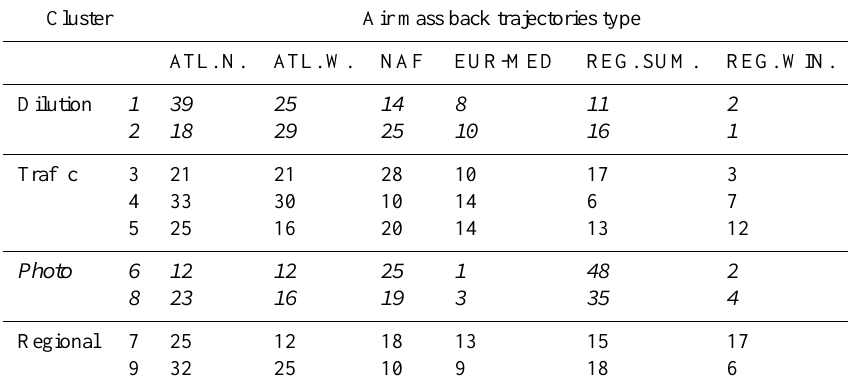
Table 3. Occurrence (%) of different air mass types for each of the nine DMPS cluster. Air mass classification types: Atlantic North (ATL. N), Atlantic West (ATL. W), North African (NAF), European-Mediterranean (EUR-MED), Regional during summer times (REG. SUM.) and Regional during winter times (REG. WIN.) Bold text are for particularly low and-or high values. Cluster Air mass back trajectories type ATL.